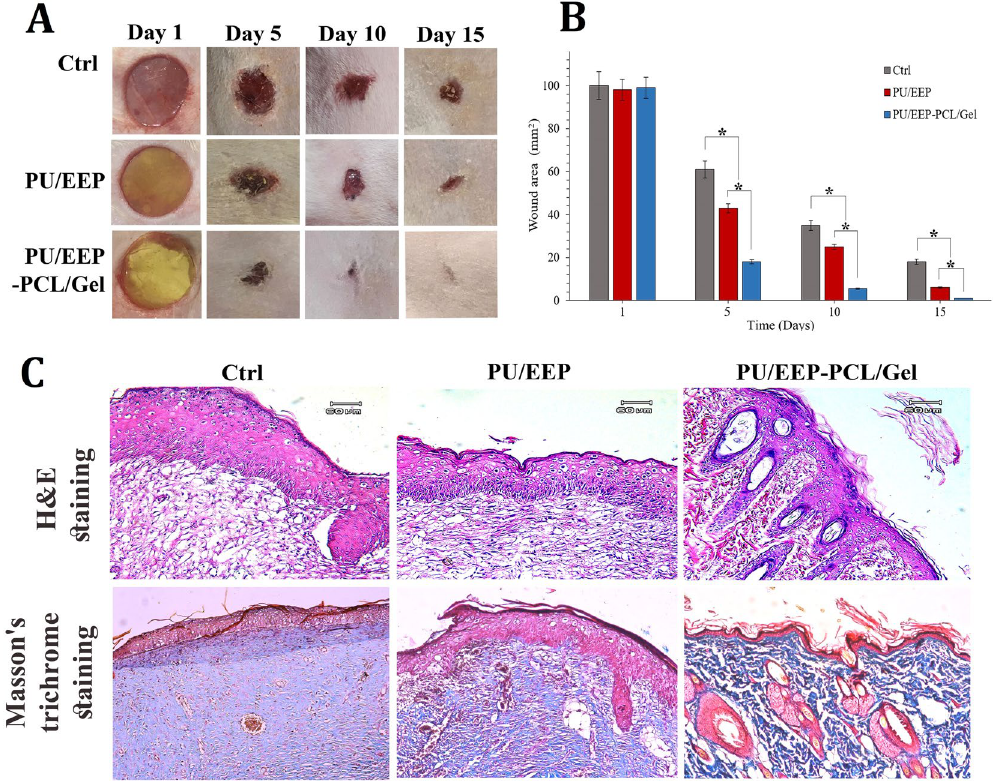
Figure 9. ( A ) Macroscopic photographs of the wounds at definite time points (1 st , 5 th , 10 th and 15 th day after wound creation) to exhibit wound closure progression at different groups (Ctrl, PU/EEP, and PU/EEP-PCL/ Gel). ( B ) Wound closure progression according to calculation of the remaining wound area at definite time points (1 st , 5 th , 10 th and 15 th day after wound creation). The data are presented as mean ± SD (n = 8). ( C ) Photographs of the H&E and Masson’s trichrome stained sections of the healed skin specimens at the 15 th day after wound